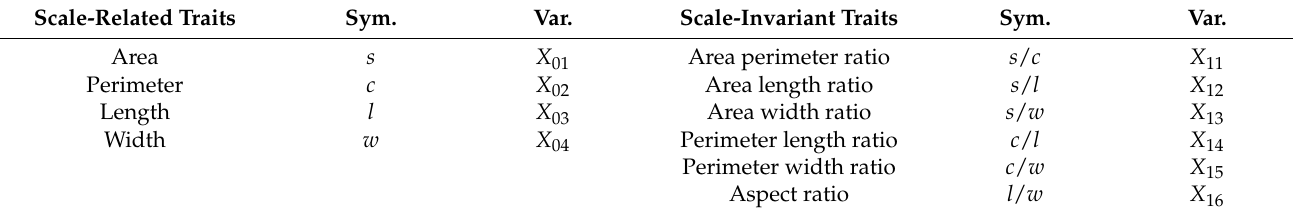
Table 2. Morphological traits. Sym.: symbols of the traits. Var.: variables.